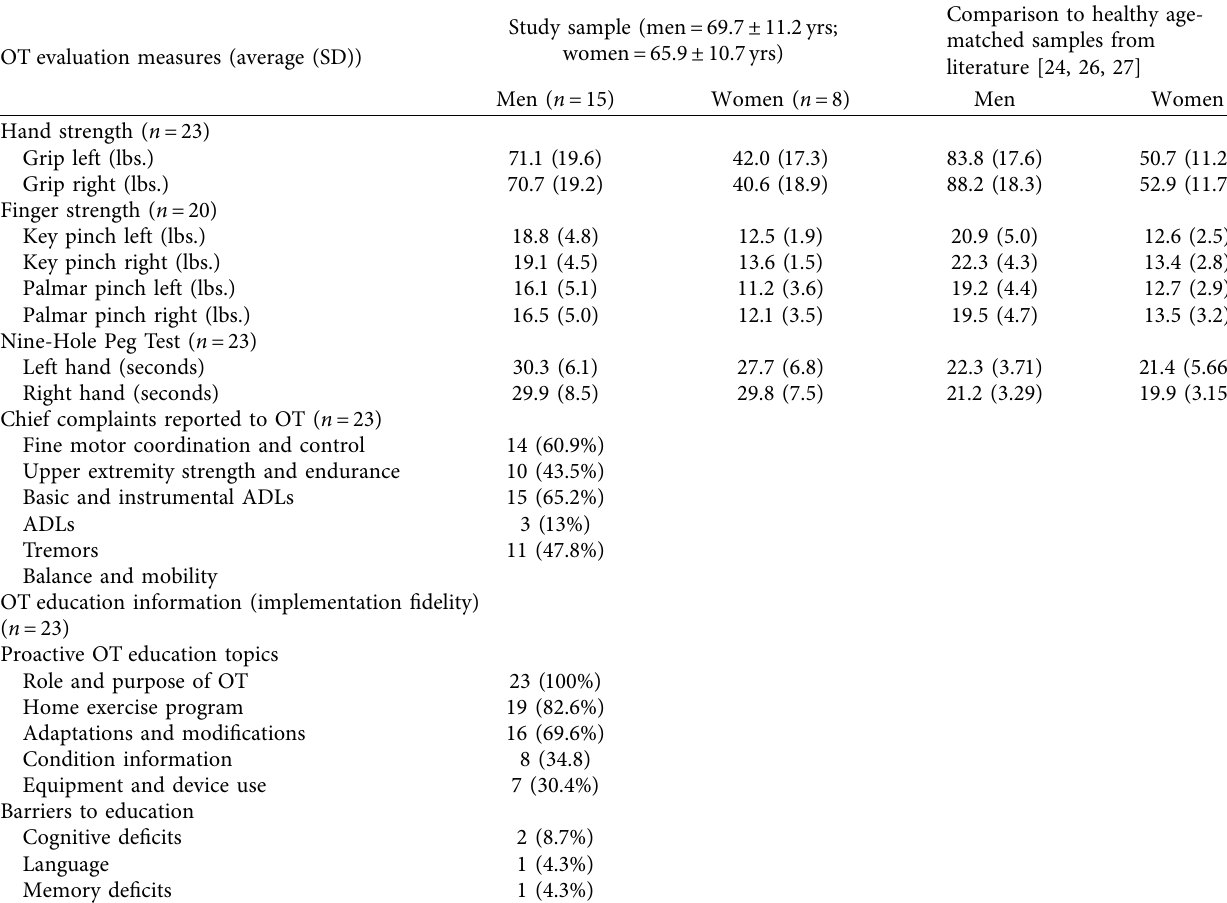
Table 2: OT evaluation measures and treatment information ( n �